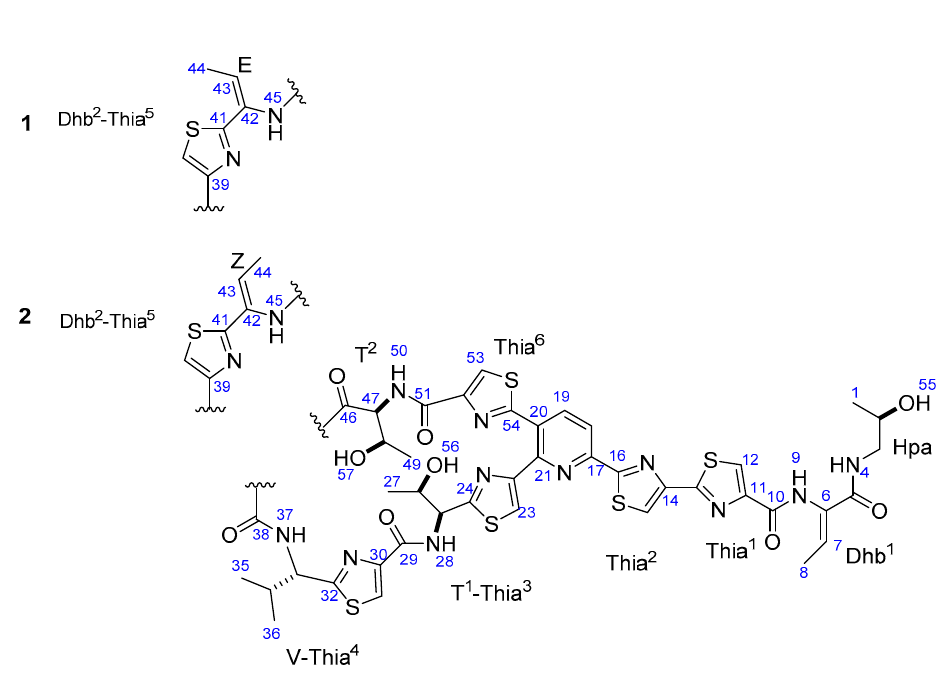
Figure 1. This assumption was supported by comparison of the optical rotation and NMR data of 1 with those of 2 , the configuration of which was confirmed by total synthesis [6,10].